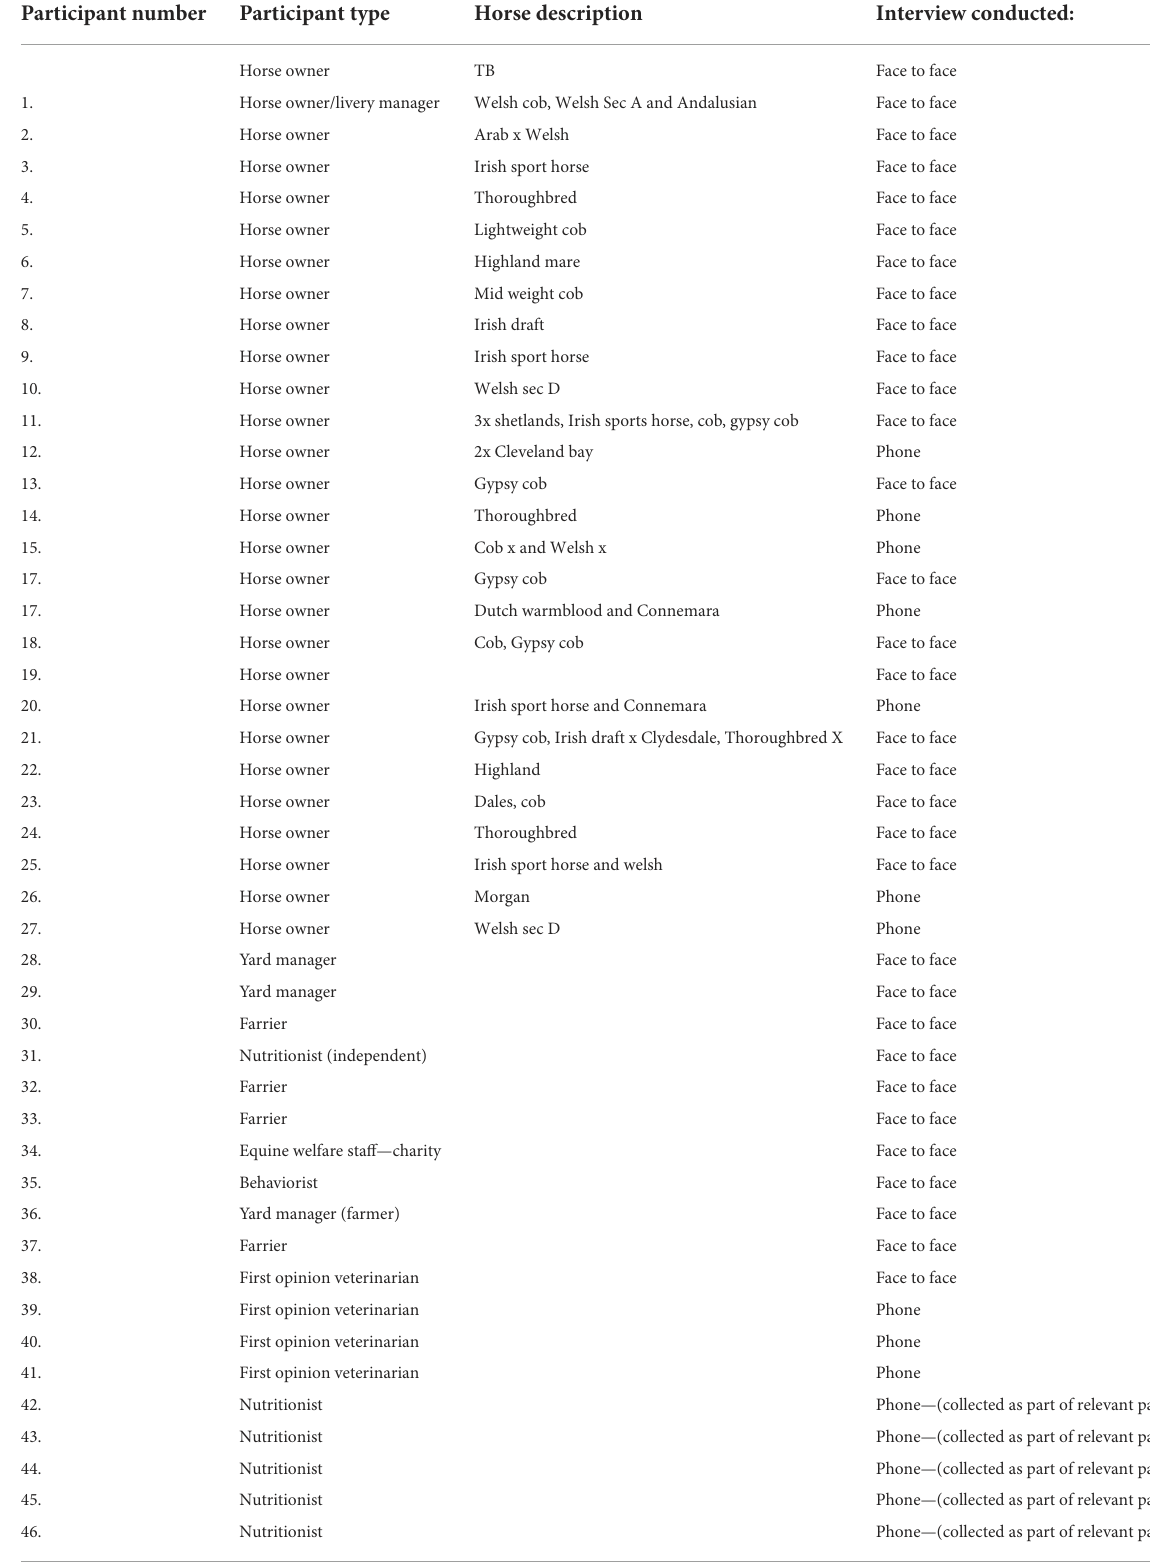
TABLE 1 Horse owning and equine professional participants in the interview phase of the